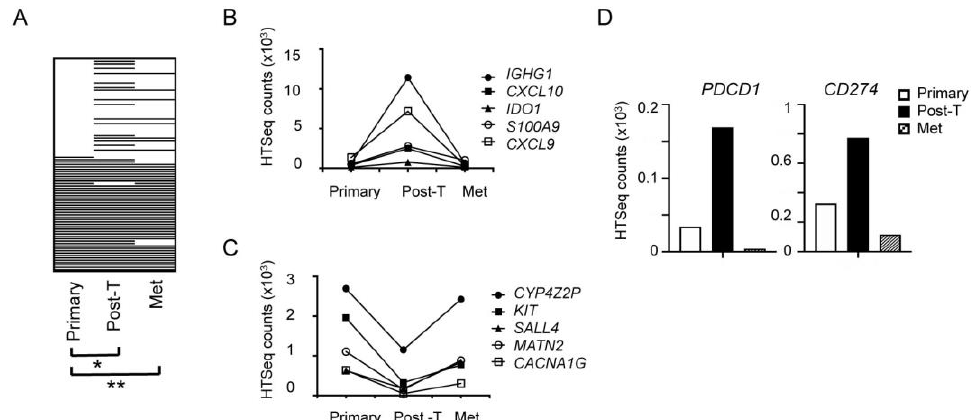
Figure 6. Dynamic PAGES-HBC changes in longitudinal samples of primary, post-neoadjuvant trastuzumab treated, and recurrent tumors from a single patient. ( A ), Heat map of PAGES-HBC, white bar, Group 1 level expression; black bar, Group 2 level expression; * p = 0.03; ** p = 0.65. ( B ), Expression of the genes that are transiently upregulated in trastuzumab-treated sample, ( C ), Expression of the genes that are transiently downregulated in trastuzumab-treated sample. ( D ), Transient upregulation of PDCD1 (PD-1) and CD274 (PD-L1) in trastuzumab-treated sample. Post-T, post-trastuzumab; Met, metastasis.